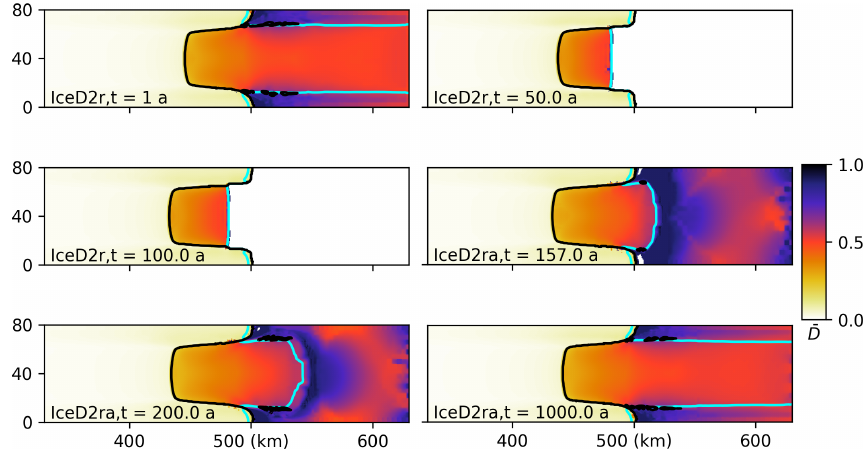
Figure 6. Comparison of the retreat and recovery due to changes in calving front position (experiments IceD2rr and IceD2ra in MISMIP + ). A melt rate of 100ma − 1 is applied, where x > 480km results in a remnant ice shelf whose damage field resembles the initial state in their common area but grows somewhat toward the front (IceD2r). Loss of buttressing leads to grounding line (solid black contour) retreat. Once the melt rate is set to zero (IceD2ra) the calving front advances, carrying a region of elevated damage with it across the domain edge. Thin, damaged ice downstream from the h = 200m contour (cyan) forms from direct accumulation on the sea surface.